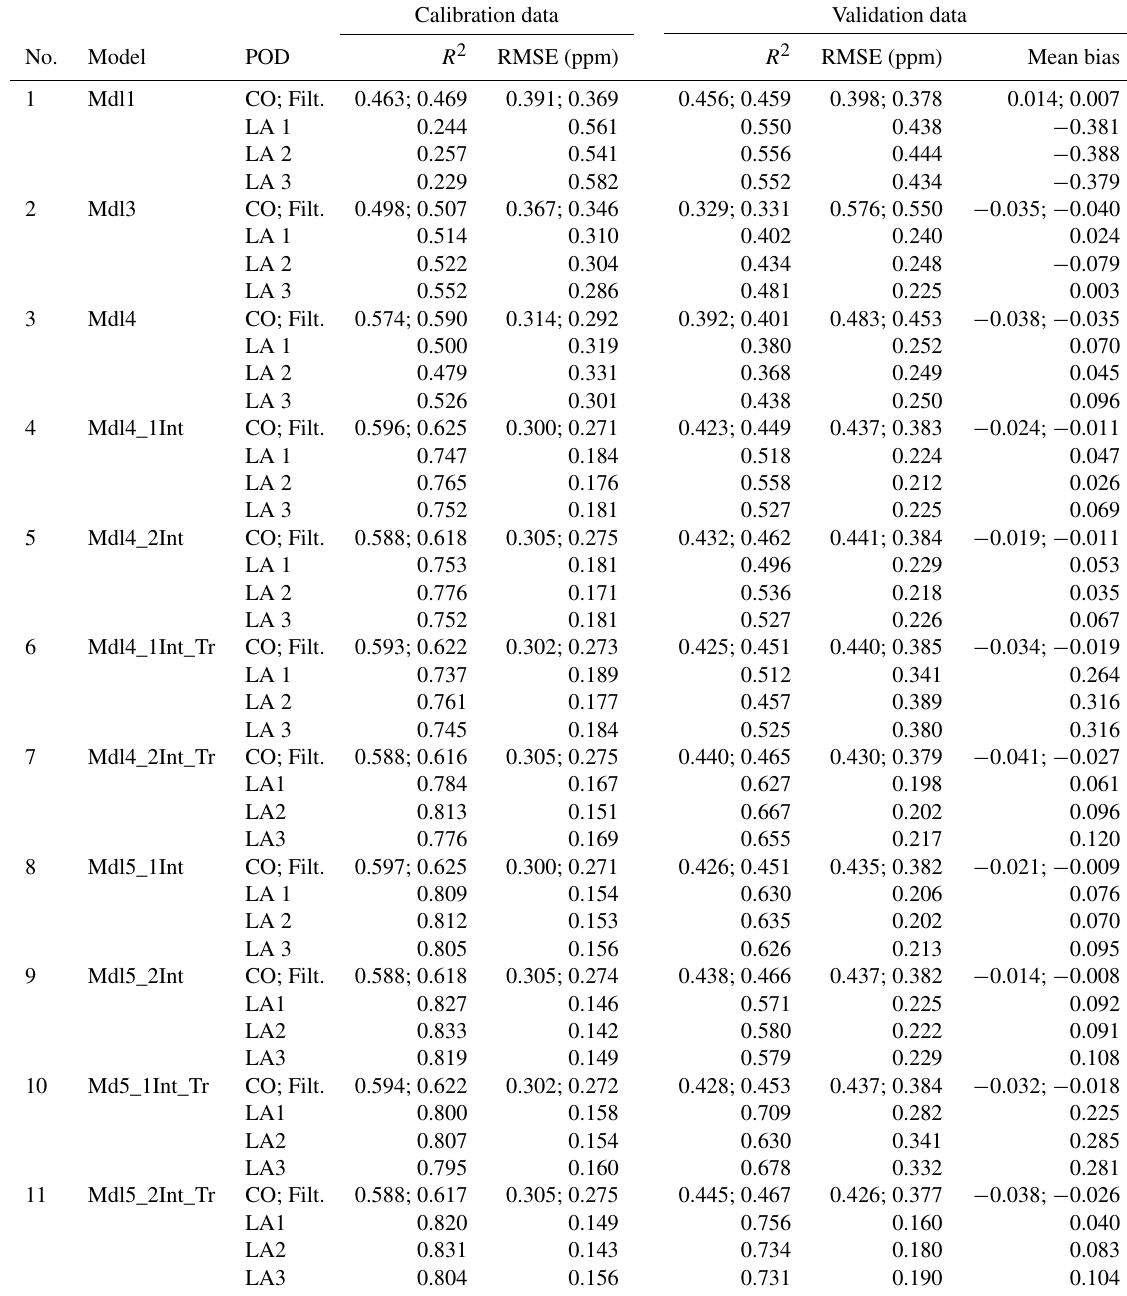
Table 3. Calibration model generation and validation